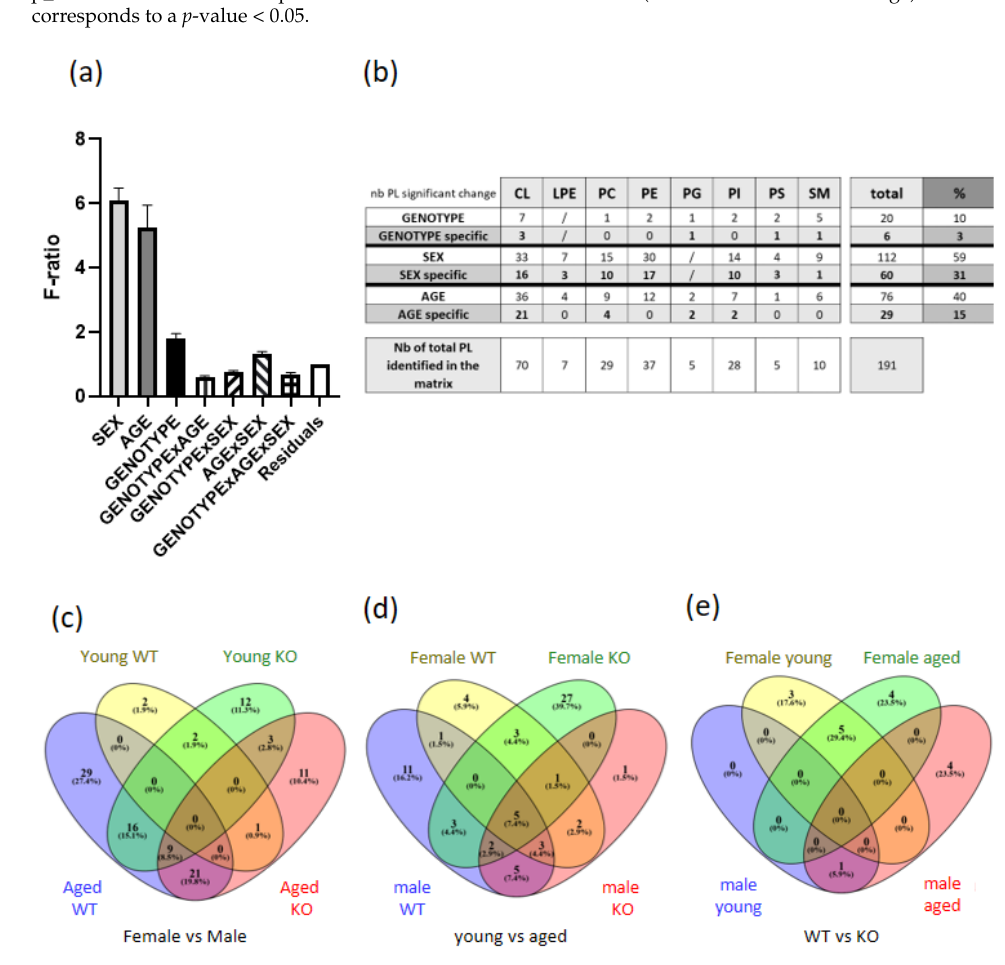
Figure 2. Diaphragm phospholipidomic investigation. ( a ) F-ratio analysis. ( b ) ANOVA analysis. ( c ) Number of significant PLs between male and female in young WT, young KO, aged WT and aged KO groups. ( d ) Number of significantly different PLs between young and aged in female WT, female KO, male WT and male KO groups. ( e ) Number of significantly different PLs between WT and KO in female young, female aged, male young and male aged groups.